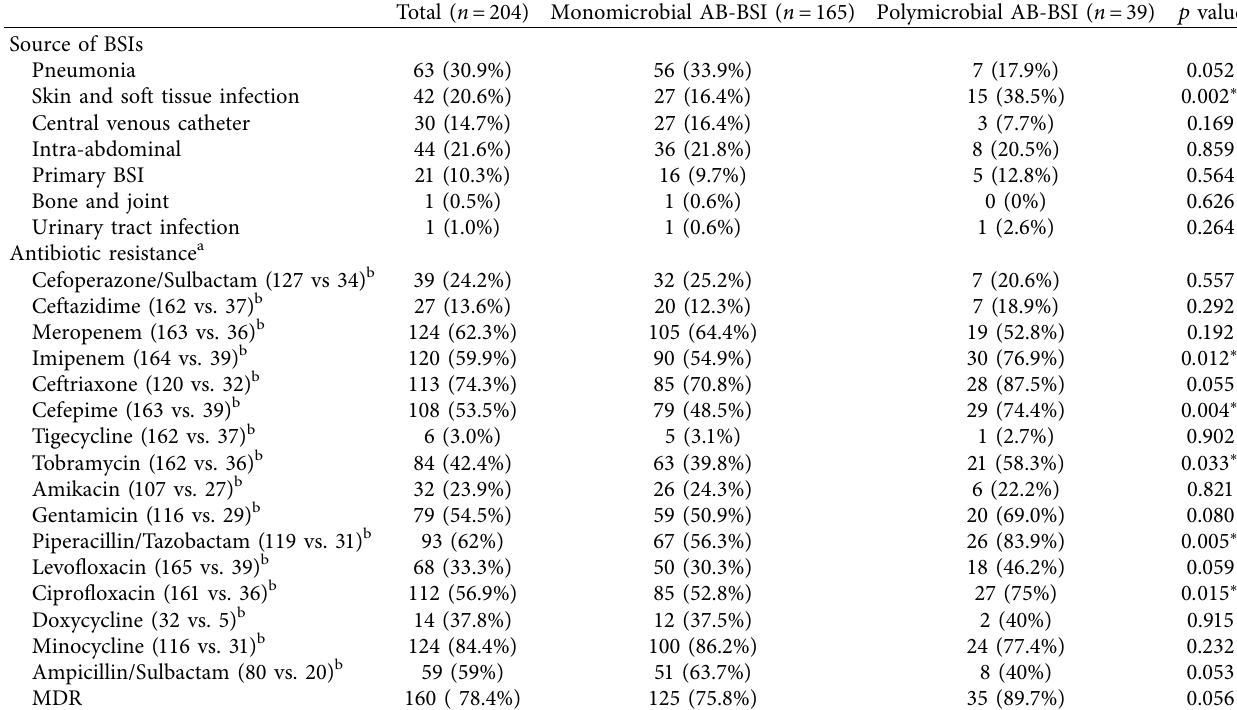
Table 3: Comparison of the microbiological characteristics with monomicrobial AB-BSI and polymicrobial AB-BSI.